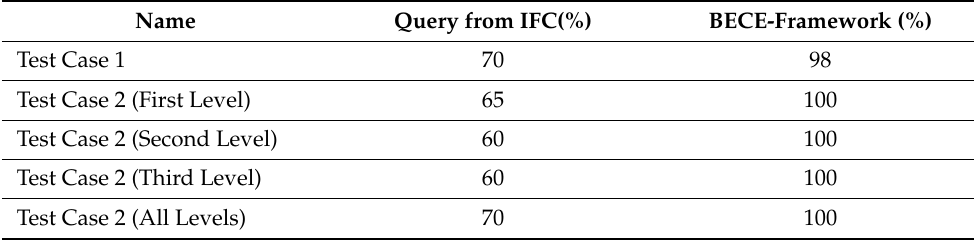
Table 8. The percentage of correct extracted adjacent spaces for two test